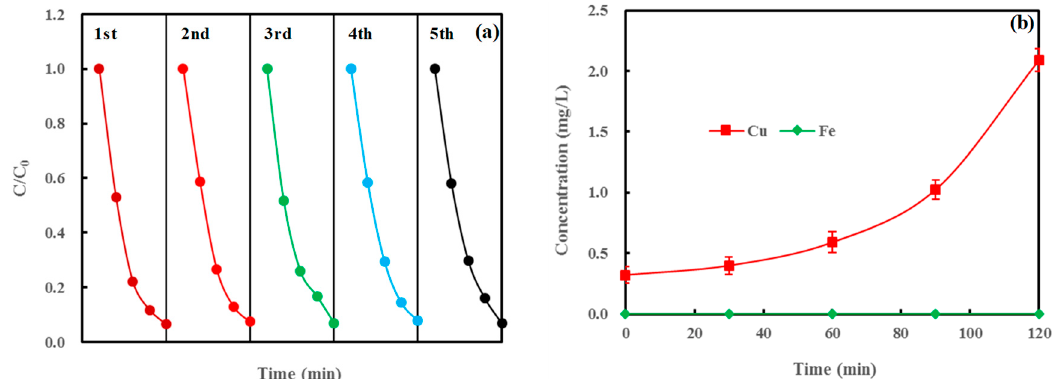
Figure 8. ( a ) Photocatalytic degradation cycle of MB on ND/LDH; and ( b ) leakage of Cu and Fe from ND/LDH in the reaction solution. (Error bars represent standard deviation of triplicate runs).